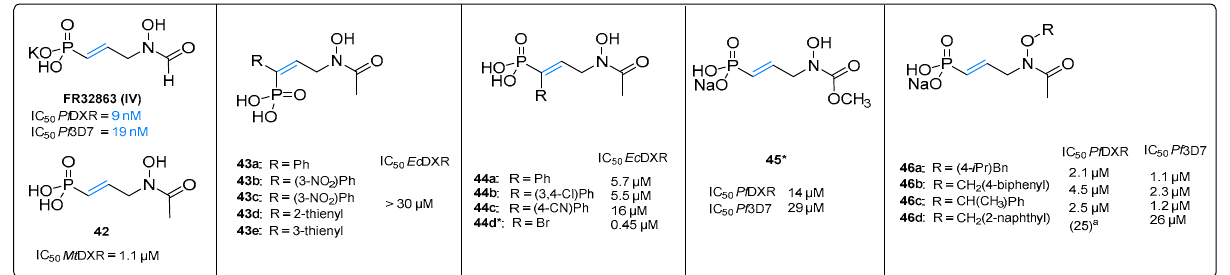
Figure 14. Biological activity of the fosmidomycin and FR900098 derivatives ( 42 – 46 ) with an α , β - unsaturated linker . * Ammonium salts were prepared. a Values in parentheses are the percent remaining enzyme activity at 100 µM.